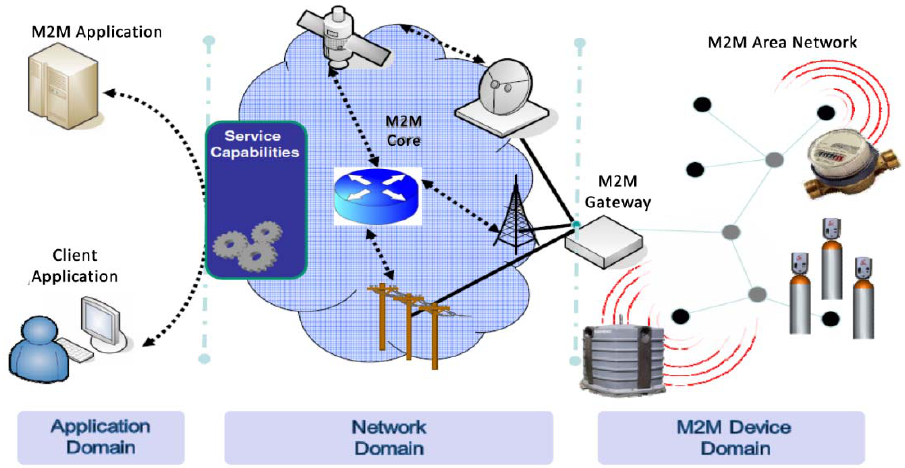
Figure 5. Main domains of the ETSI M2M reference architecture [23].